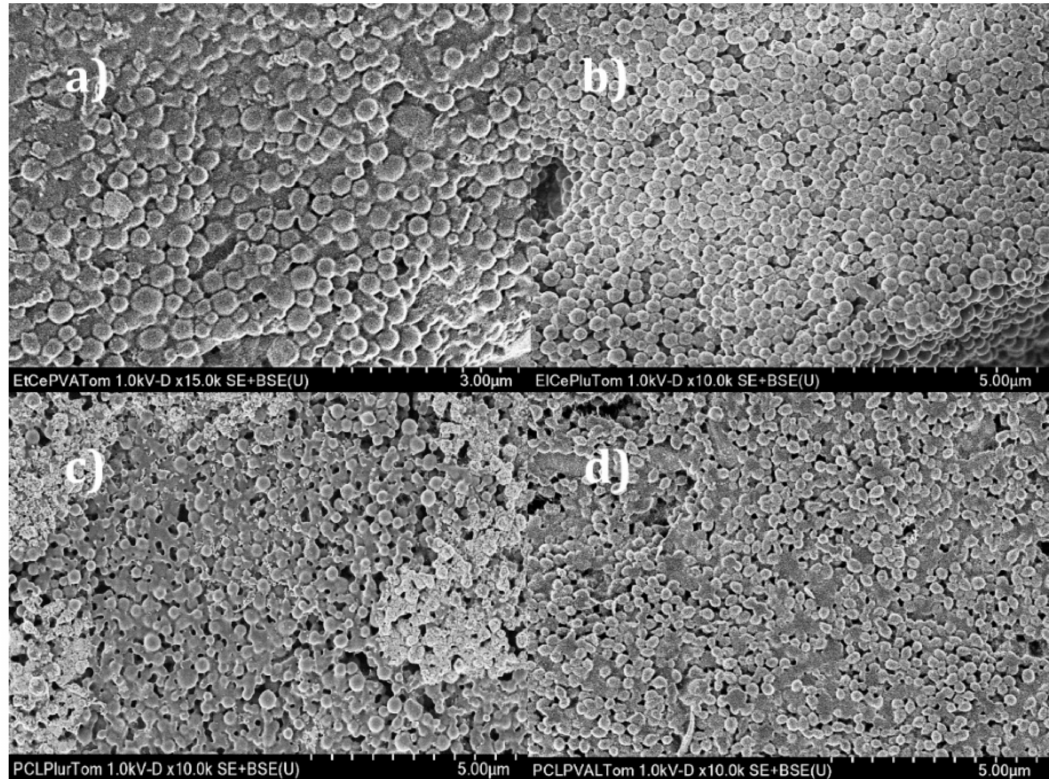
Figure2. MorphologicalcharacterizationbySEMofthepolymericnanocapsules: ( a )ethylcellulose-PVA; ( b ) ethyl cellulose-Pluronic ® F-127; ( c ) PCL-Pluronic ® F-127; ( d )